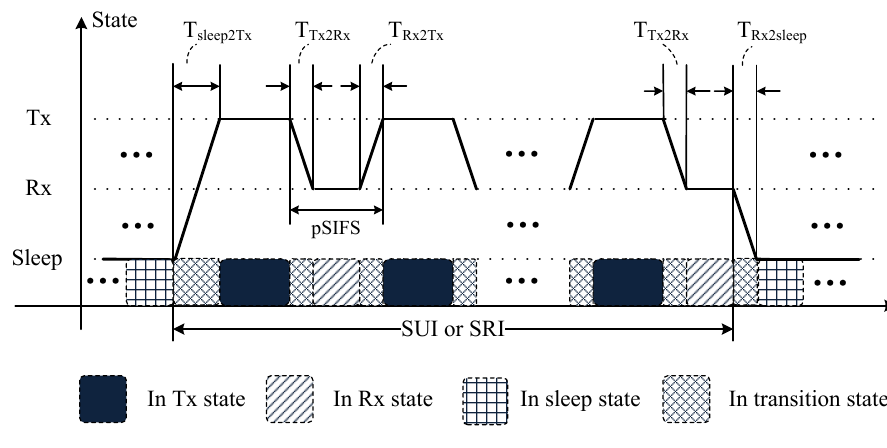
Figure 5. Energy consumption in one SUI or